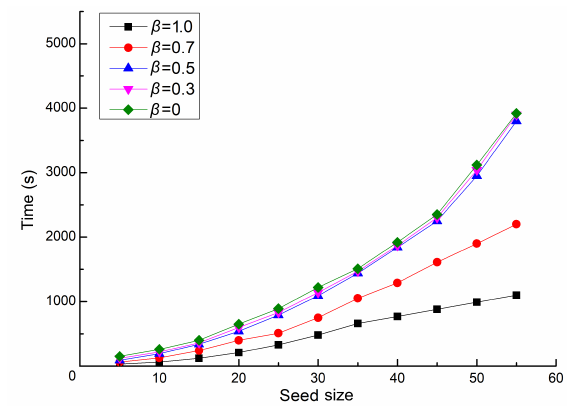
Fig. 5 Running time under different